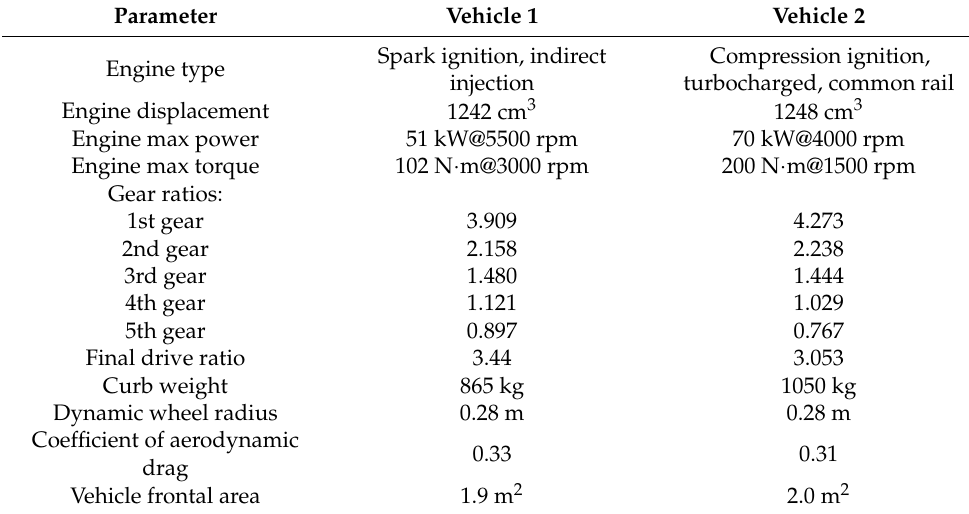
Table 1. Key parameters of the vehicles used for acquisition of the measured